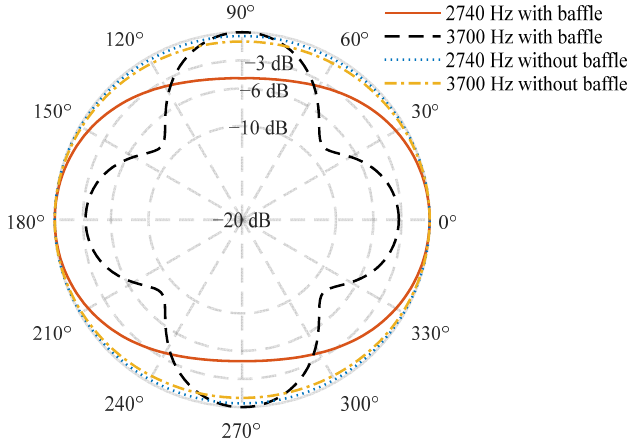
Figure 6. Vertical directivity diagrams.